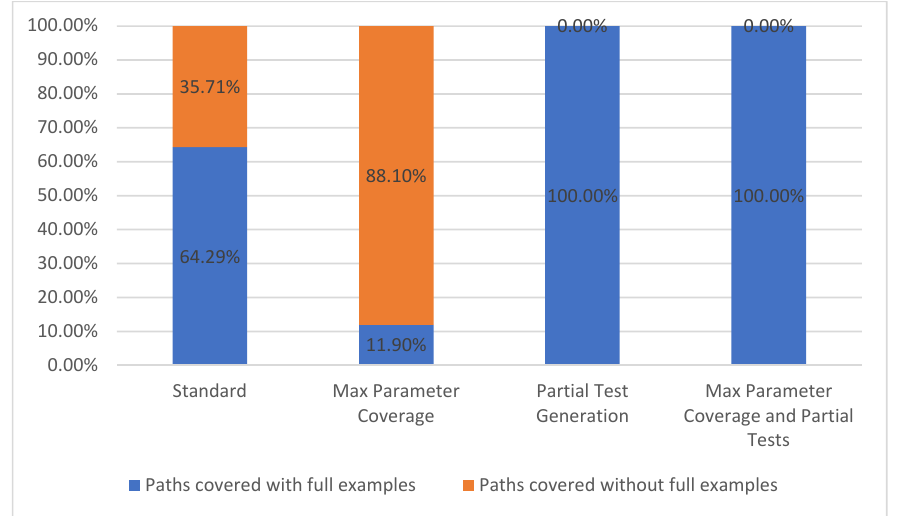
Figure 7. Path coverage.